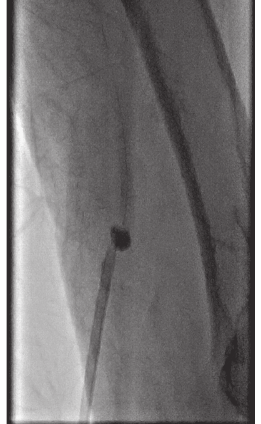
Figure2:RetrievaloftheinnerblockingballoonoftheMYNXGRIP and of the sheath towards the puncture site. Note the slight shift between the sheath and the blocking balloon indicating appropriate wall